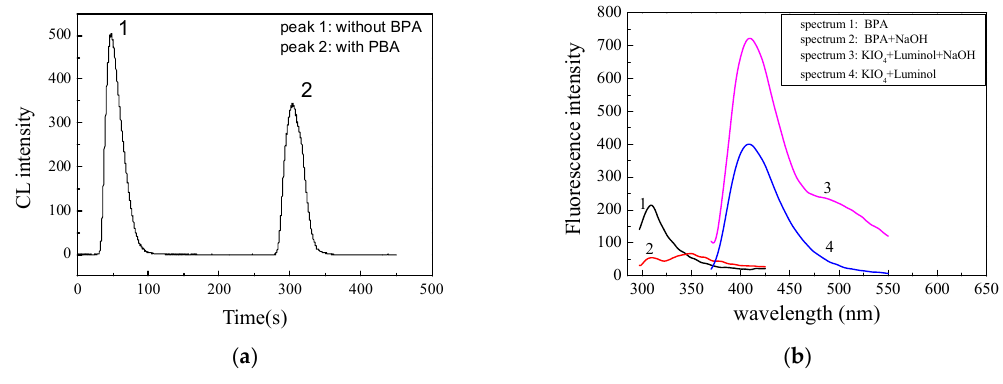
Figure 6. Spectra comparison in the presence and absence of BPA. ( a ) CL spectra; and ( b ) fluorescence spectra.